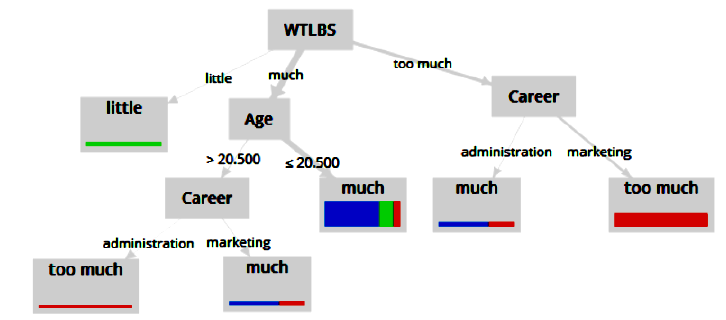
Figure 4. The predictive model 2 on the use of the web application for the teaching-learning process on bank savings (source: created by